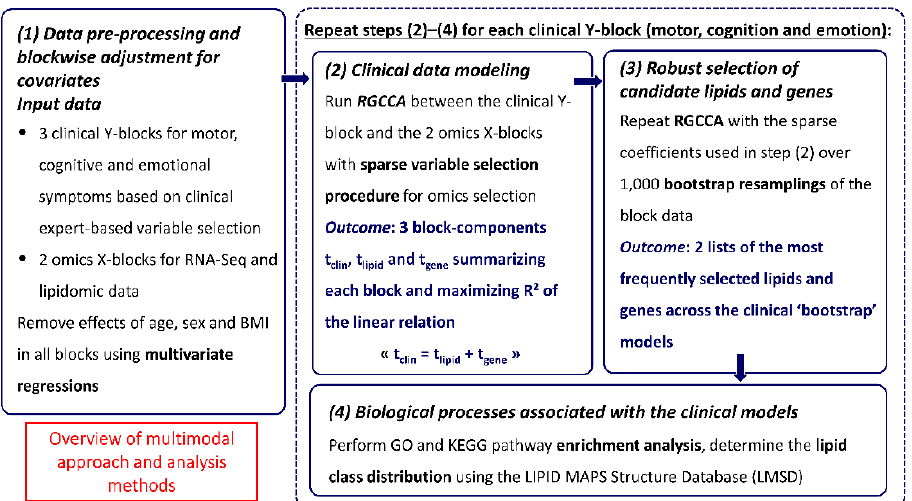
Figure 1. Workflow of the multi-omics data integration approach using RGCCA.